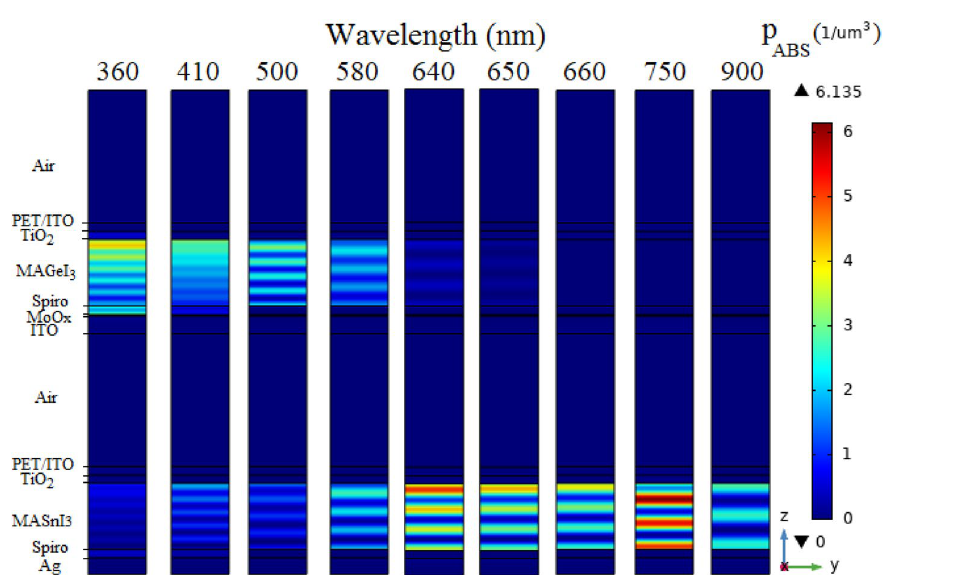
Figure 2. The absorption density profiles of the proposed tandem architecture shown in Fig. 1c for several